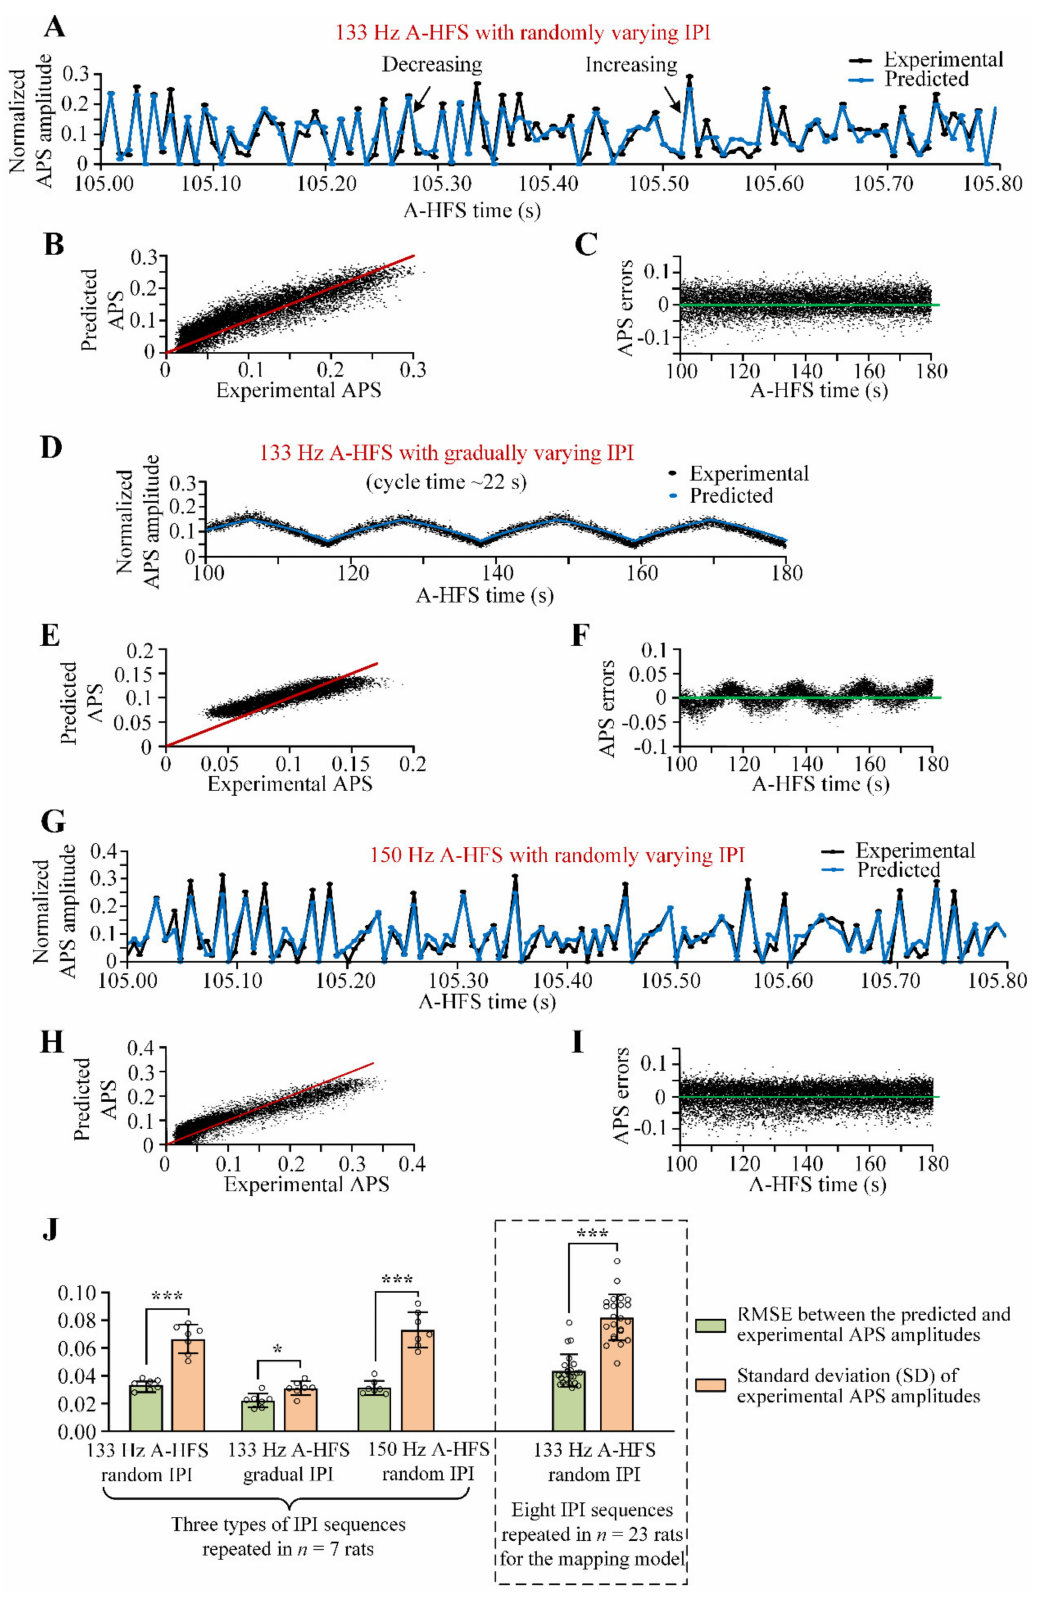
Figure 3. Using the mapping model of normalized APS amplitude (NAA) = max [0.027 × (1.5 × IPI 1 − IPI 2 ), 0] to predict the neuronal responses to A-HFS with different types of varying IPI. ( A – I ) Comparison of the predicted APS amplitudes and experimental APS amplitudes (normalized) during a 133 Hz A-HFS sequence with randomly varying IPI ( A – C ),